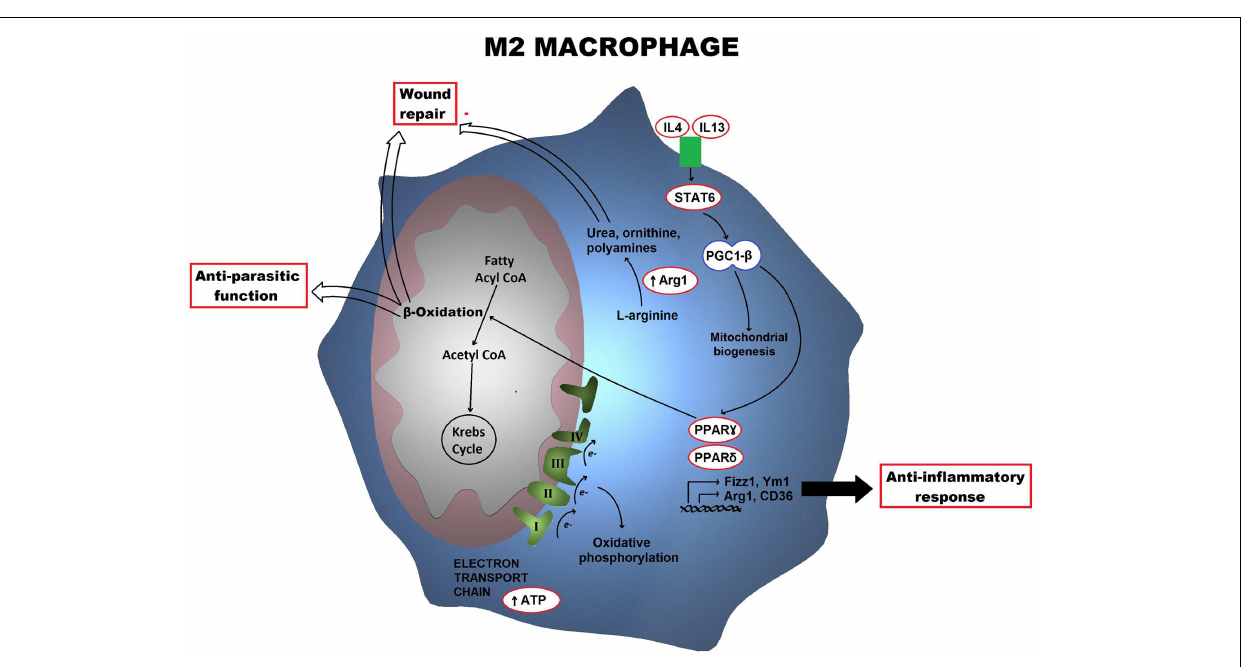
STAT6 and PGC-1 β . Arg1 also drives the production of polyamines and ornithine.The key functional consequences are tissue repair and anti-parasitic